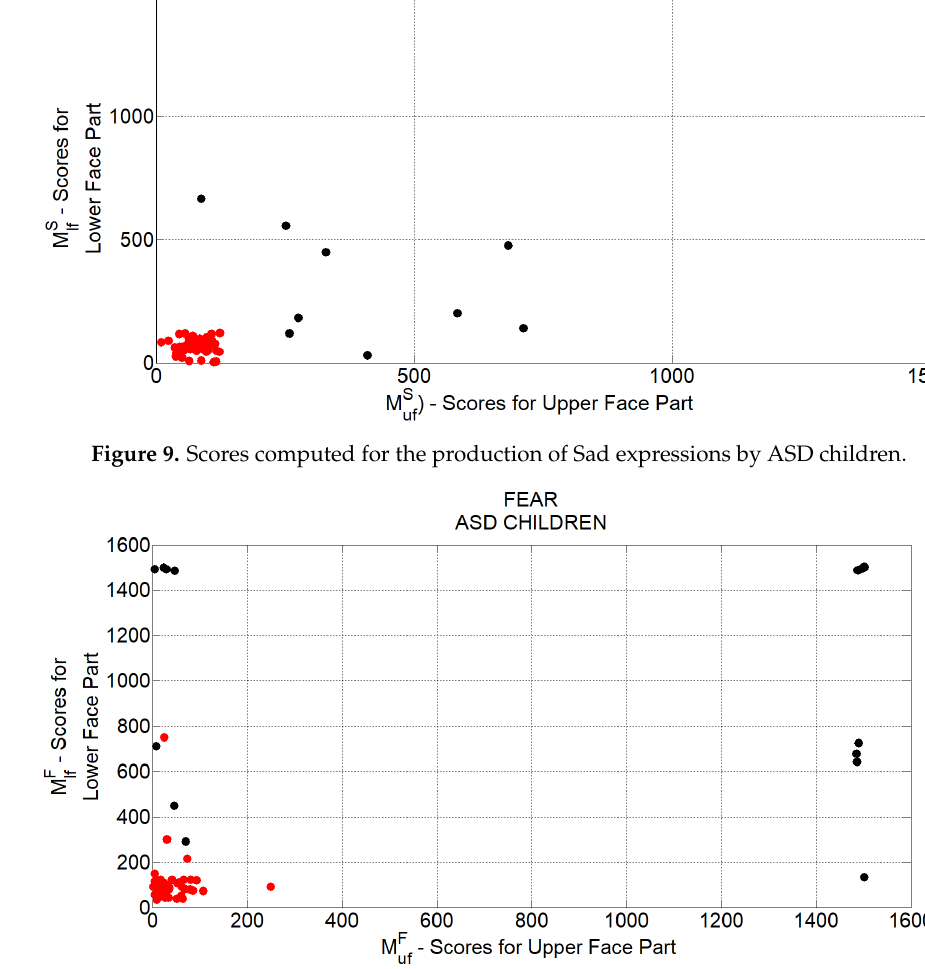
Figure 10. Scores computed for the production of Fear expressions by ASD